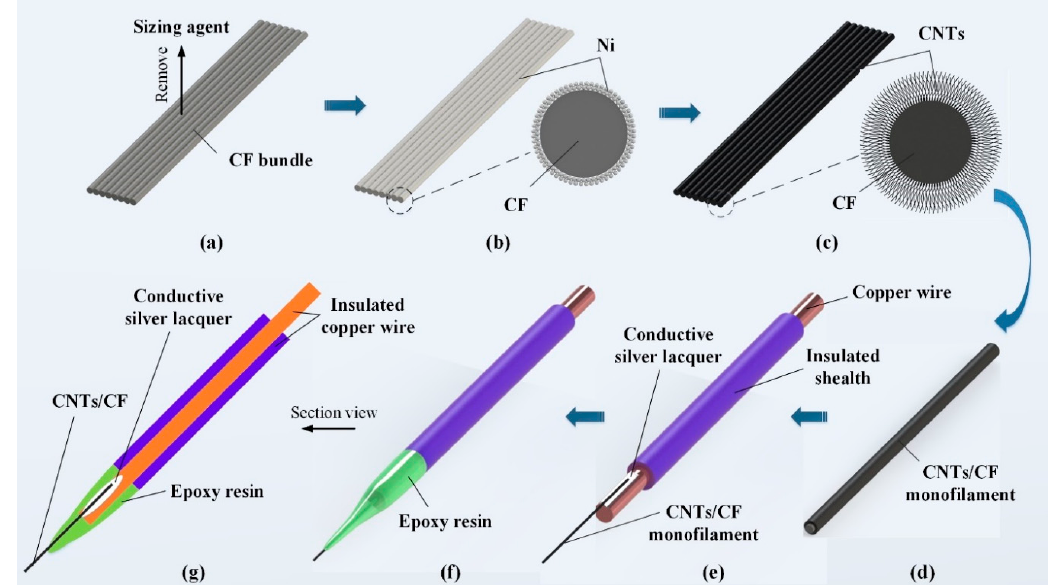
Figure 1. The fabrication process of a CNTs/CFME. ( a ) Pretreatment of the CF bundle surface; ( b ) nickel electroless plating; ( c ) CNTs grafting; ( d ) separating a CF monofilament; ( e ) connecting the CF monofilament to an insulated copper wire; ( f ) encapsulation with epoxy resin; ( g ) section view of the CNTs/CFME structure.